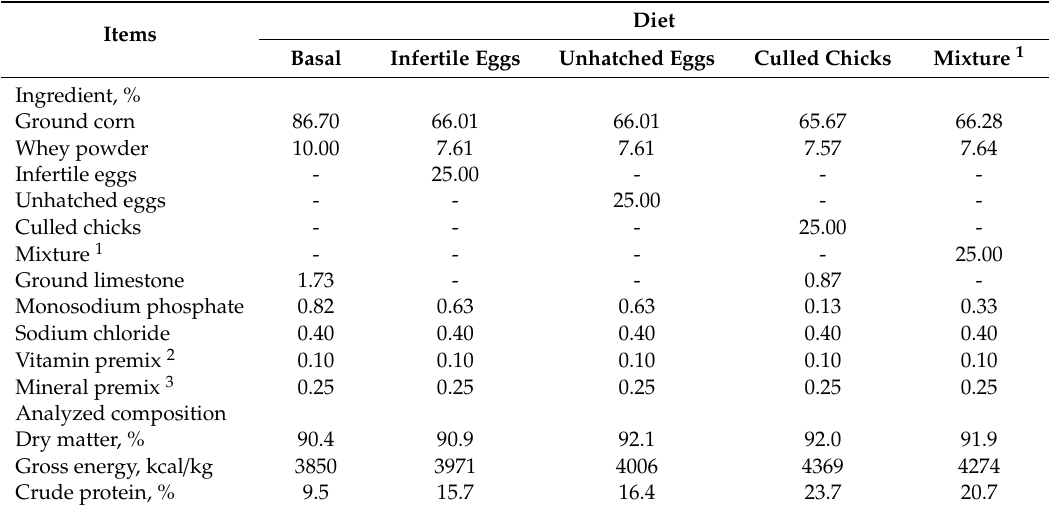
Table 1. Ingredients and chemical compositions of the experimental diets (as-fed basis) in Experiment 1.